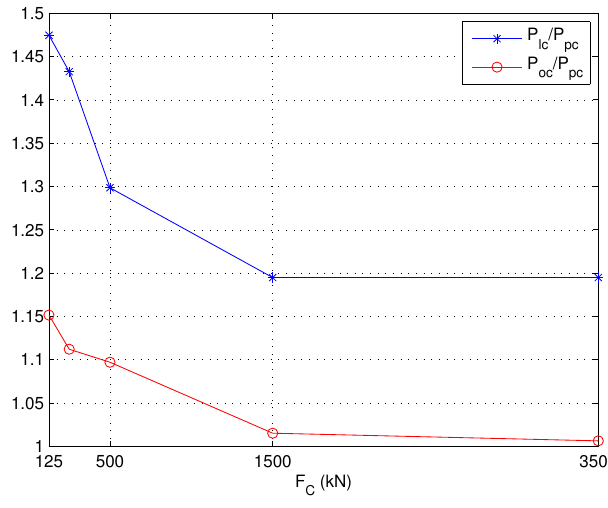
Figure 10. Ratio between the average absorbed power when two different optimal geometries are adopted for constrained LC ( P lc / P pc ) and PSOC ( P oc / P pc ). The PTO is subject to device motion constraints ( k C = 0.75) and force constraints (defined by F C